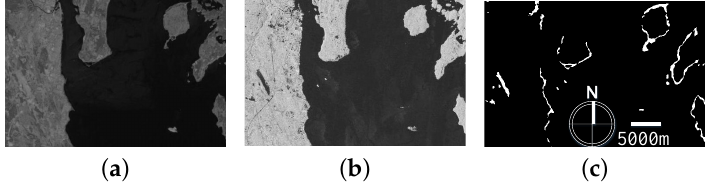
Figure 11. The Campbell River dataset: ( a ) the SAR image acquired in June 1999, ( b ) the SAR image acquired in June 2010, and ( c ) the reference